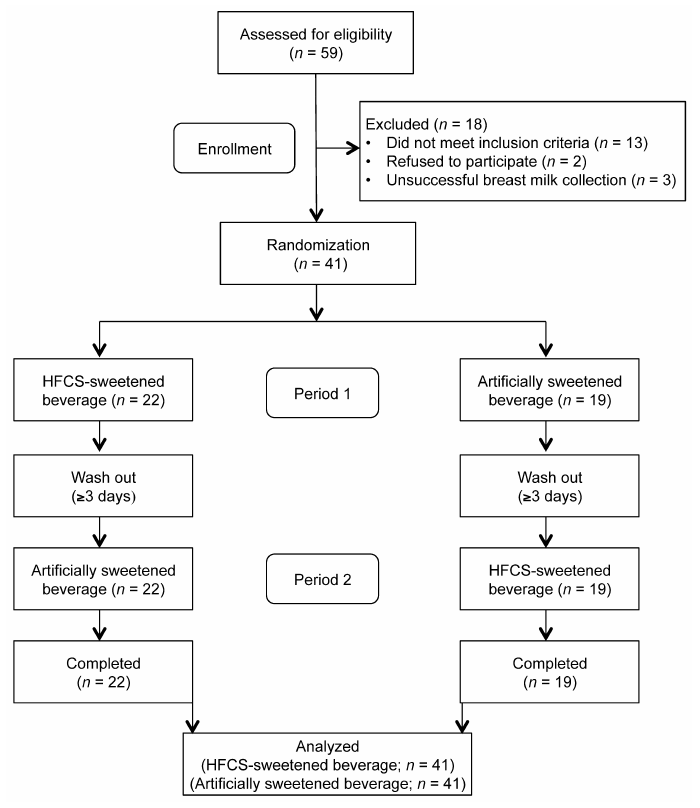
Figure 1. Flow diagram of participants. Table 1. Baseline characteristics of the participants at six weeks postpartum.